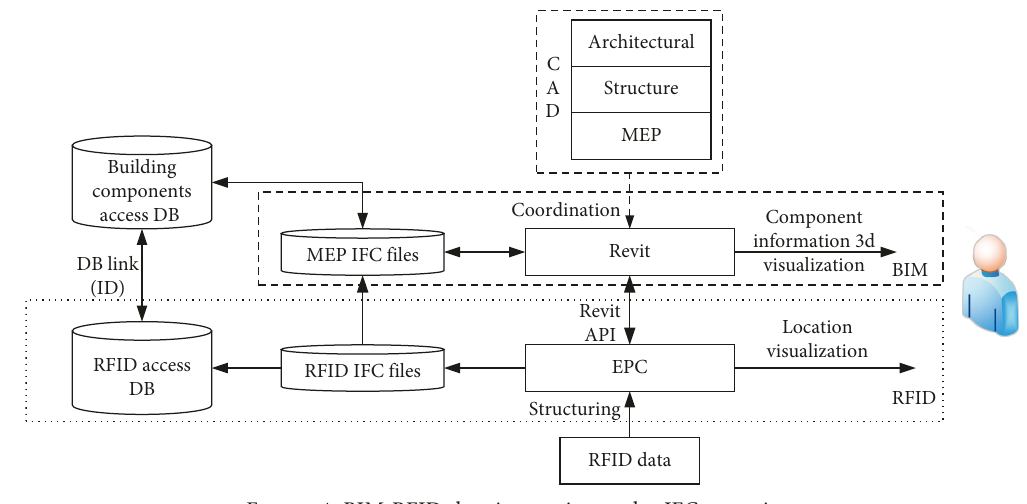
Figure 4: BIM-RFID data integration under IFC extension.